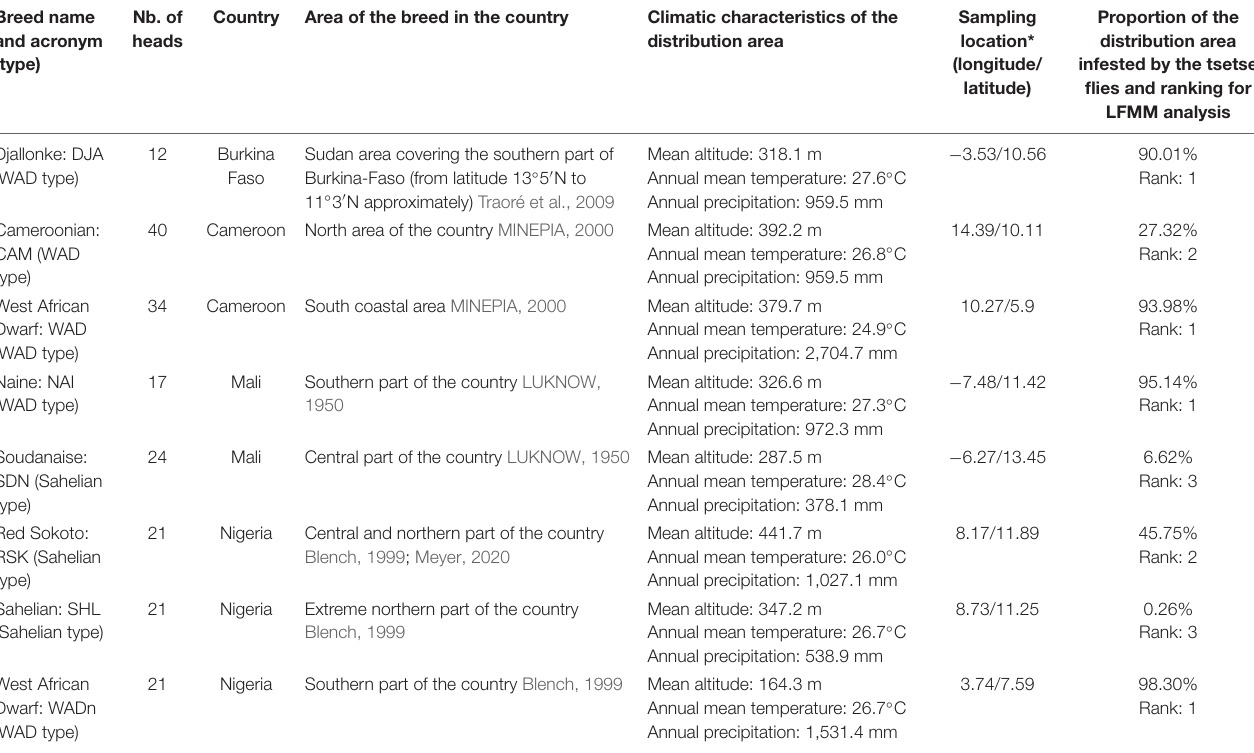
TABLE 1 | West-Central African goat